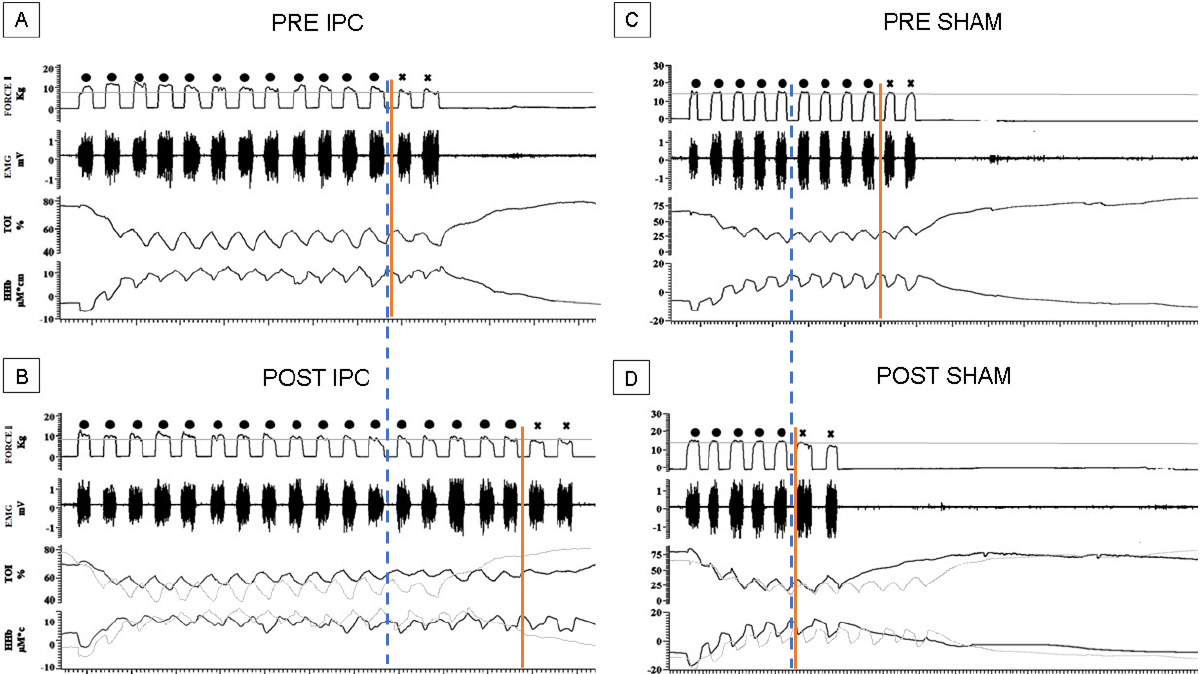
Figure 3. Exercise task. Original recordings from two representative subjects of the exercise task performed pre- ( A , C ) and post- ( B , D ) the IPC ( A , B ) or SHAM ( C , D ) treatment. Vertical lines indicate exhaustion time (continuous red line) and ISOtime (dashed blue line), i.e., the shortest exhaustion time in the pre- and post-treatment tasks. The dots over the force signal indicate valid contractions while the “X” indicates below-threshold contractions (after exhaustion).